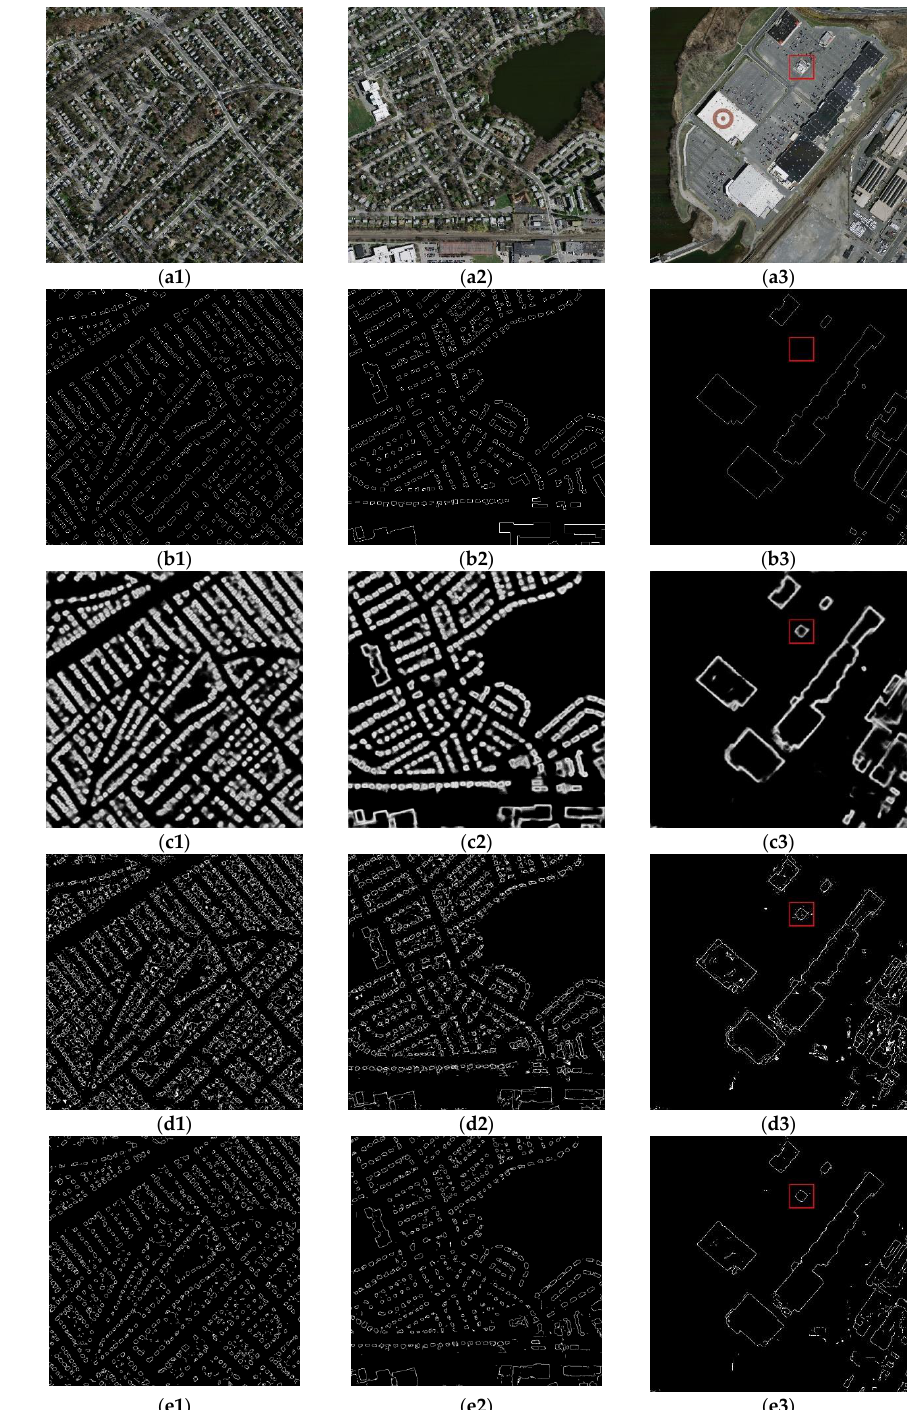
Figure 8. RCF based building edges detection results. ( a1 – a3 ) Original imagery; ( b1 – b3 ) building edges ground truth map; ( c1 – c3 ) building edges probability map generated by RCF-building; ( d1 – d3 ) building edges refinement map generated by NMS algorithm; and ( e1 – e3 ) building edges refinement map generated by involved